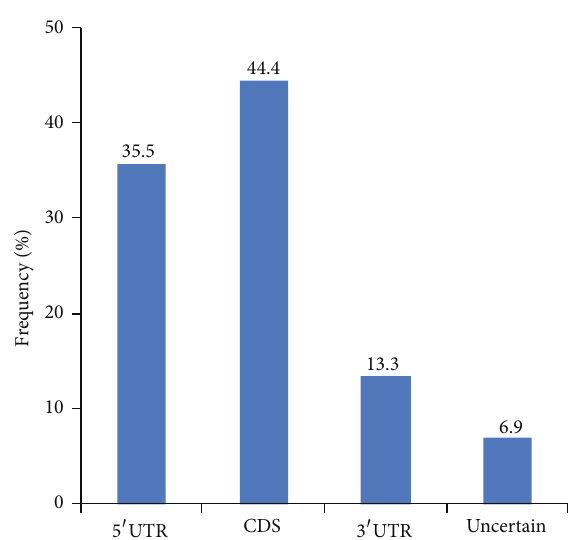
Figure 4: Frequency distribution of EST-SSRs based on locations.